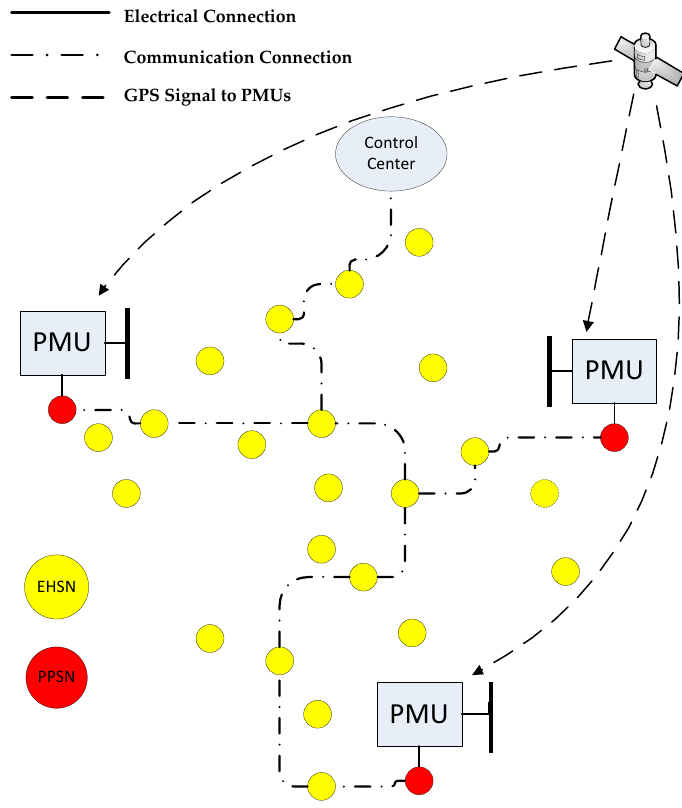
Figure 2. Communication system. PMU, phasor measurement unit; EHSN, energy harvesting sensor node; PPSN, plug-in powered sensor node.